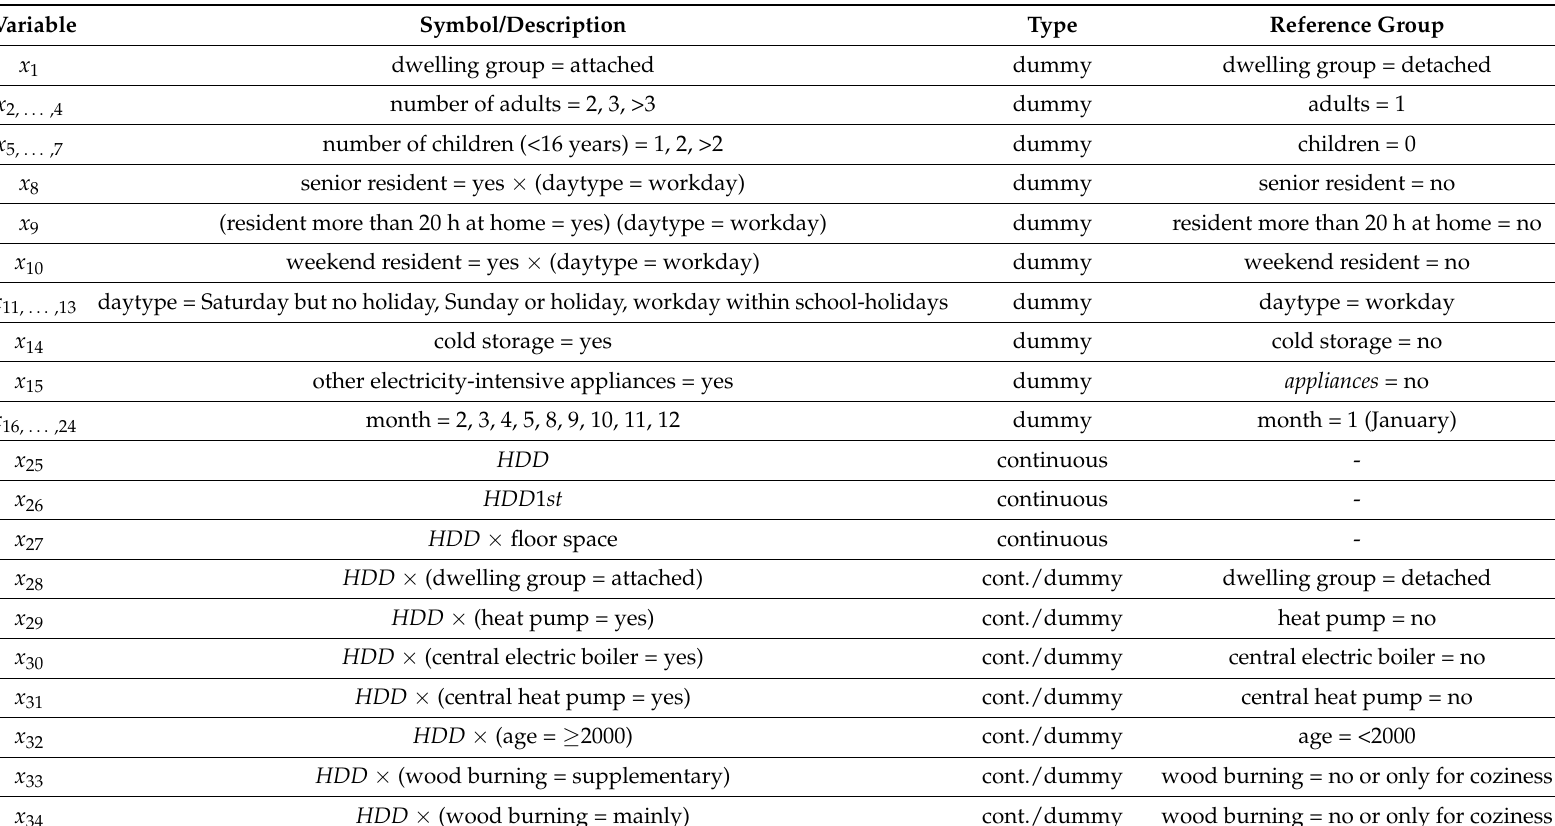
Table A1. Explanatory variables, model for hourly electricity consumption in